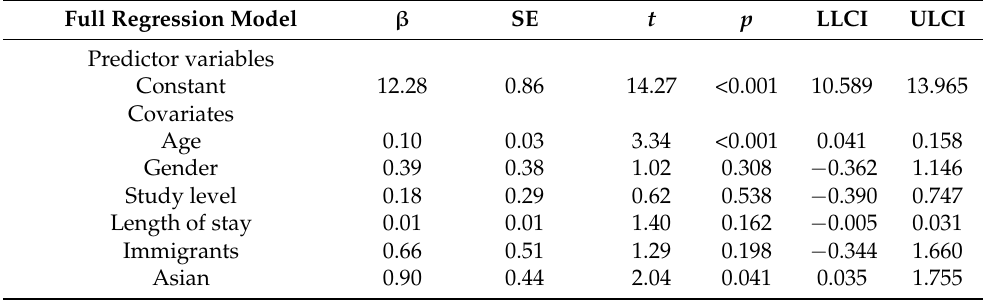
Table 5. Moderation analysis for coping strategies, Mandarin Chinese proficiency, and